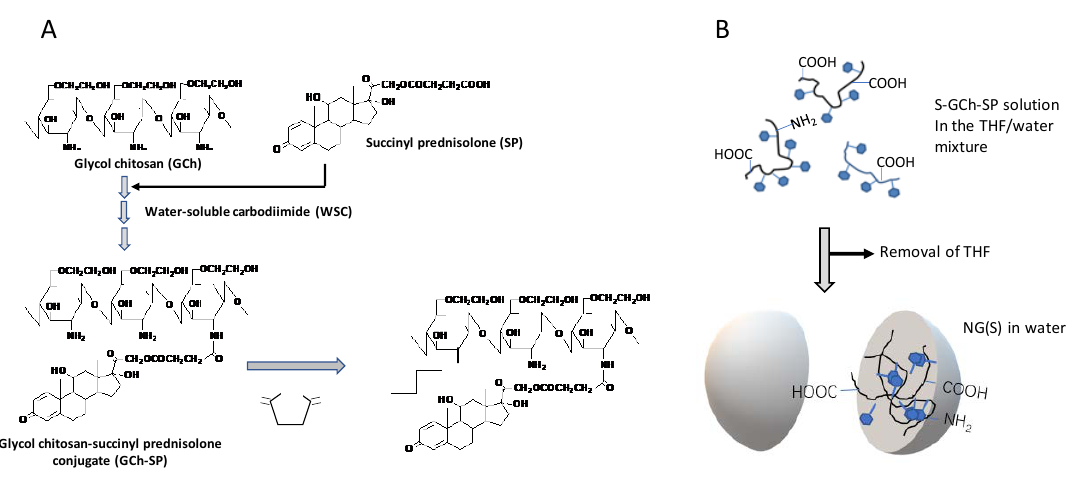
Figure 6. ( A ) Synthetic scheme of GCh-SP and S-GCh-SP. GCh: glycol-chitosan, SP: succinyl prednisolone, GCh-SP: GCh-SP conjugate, S-GCh-SP: succinylated GCh-SP, WSC: water-soluble carbodiimide, SA: succinic anhydride. ( B ) A diagram showing the formation of NG(S) in water. The structure of S-GCh-SP was confirmed from its 1 H-NMR spectrum. The mixture